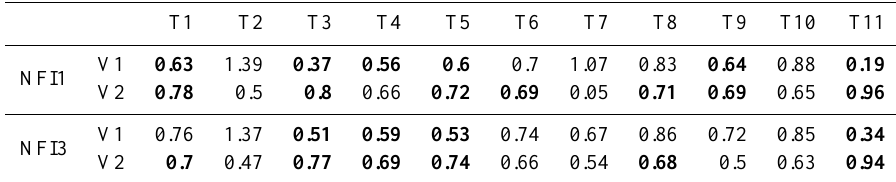
Table 3. Evaluation of model parameterization. T1: Picea abies ; T2: Larix decidua ; T3: Pinus sylvestris ; T4: Pinus cembra ; T5: Abies alba ; T6: Pinus mugo ; T7: Quercus spec. ; T8: Betula pubescens ; T9: Fraxinus excelsior ; T10: other broad-leaved species; T11: all tree species; NFI1: model results (carbon mass) for simulation year 1985 compared with NFI1 data; NFI3: model results (carbon mass) for simulation year 2006 compared with NFI3 data; V1: Euclidean distance scaled to 1 (lower values are better). To provide greater clarity, values smaller than 0.67 are written in bold; V2: percentage similarity coefficient (higher values are better). To provide greater clarity, values higher than 0.67 are written in bold. Both similarity measures were calculated by comparing the carbon mass of simulated and measured data (see for details on the calculation).